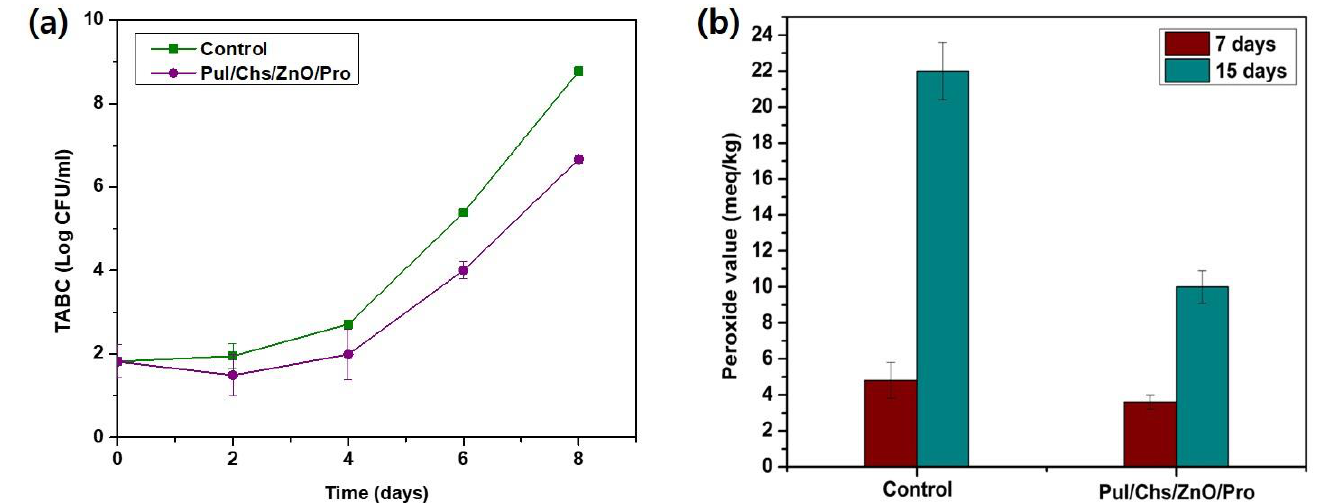
Figure 7. Application of pullulan/chitosan-based composite films for packaging of pork belly meat. ( a ) Total aerobic bacterial count, ( b ) peroxide values stored at 10 °C.